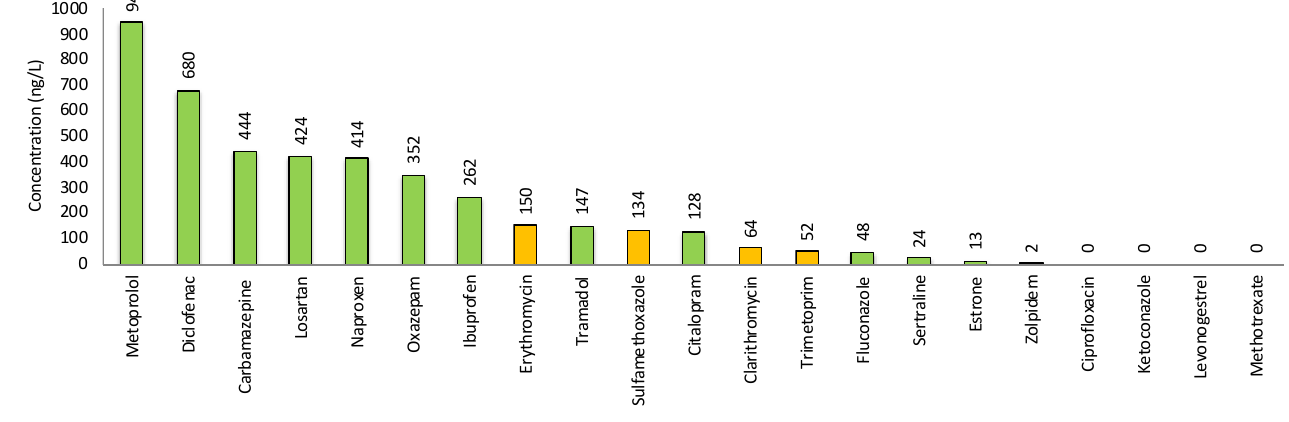
Figure 3. Average concentrations (ng/L) of the 21 analyzed pharmaceuticals in outlet water from 8 Scanian WWTPs (see Supplementary Materials Table S2). Antibiotics are marked in orange, except for ciprofloxacin, which was not found in measurable concentrations.